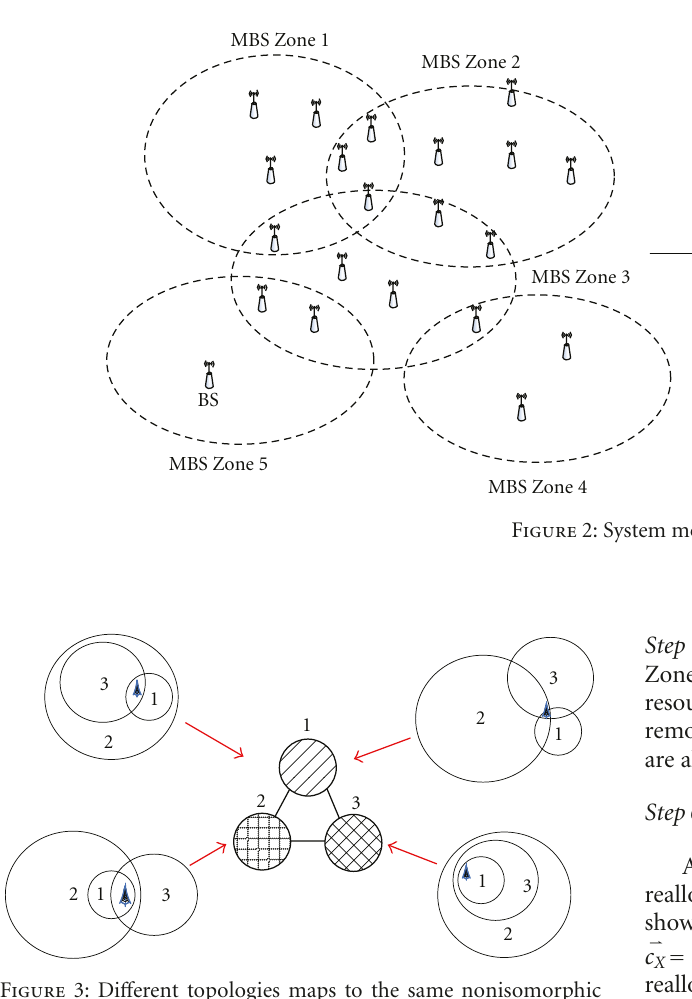
Figure 3: Di ff erent topologies maps to the same nonisomorphic